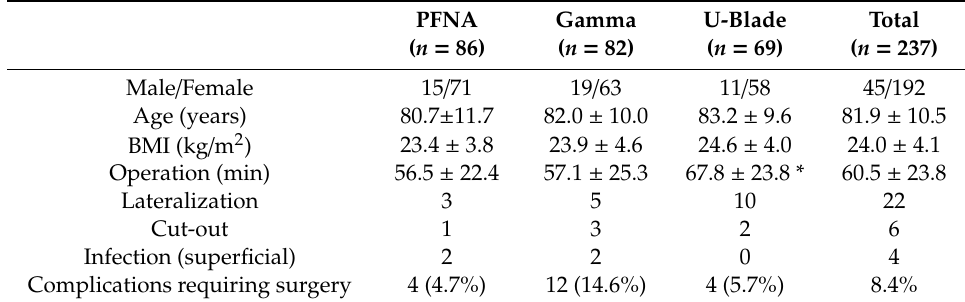
Table 1. Patients’ demographics and overall general complications.